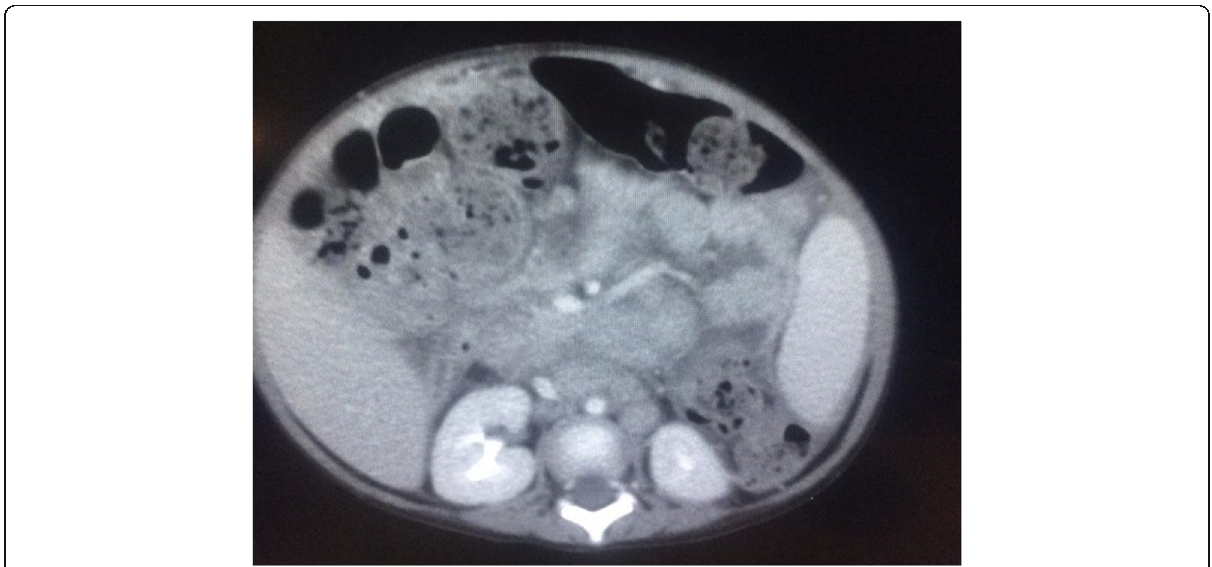
Fig. 1 Section of Abdominal CT Scan reveals multiple para-aortic lymphadenopathies forming a conglomerate mass, and mesenteric